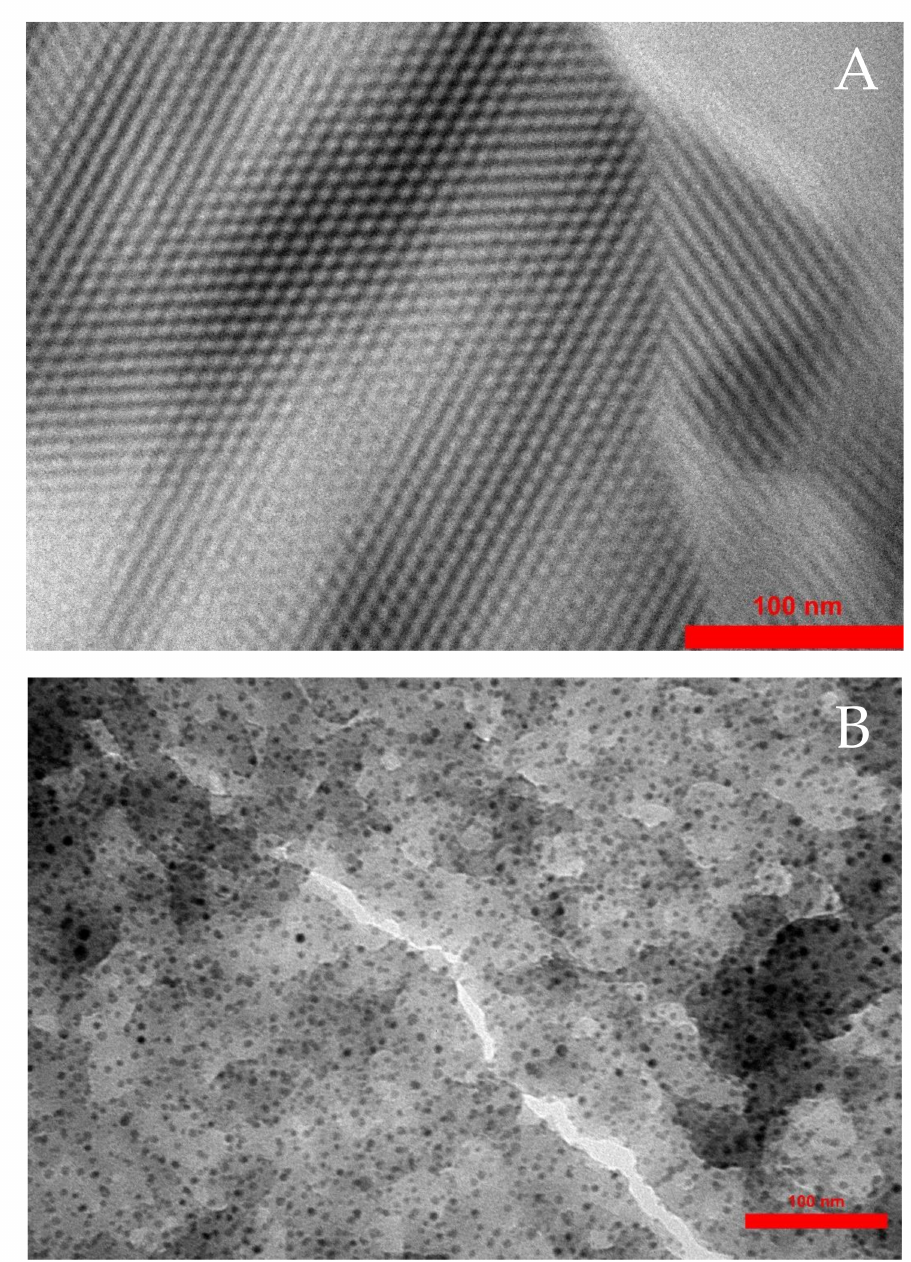
Figure 7. Transmission electron microscopy micrographs of C–PS ( A ), and Pd@C–PS ( B